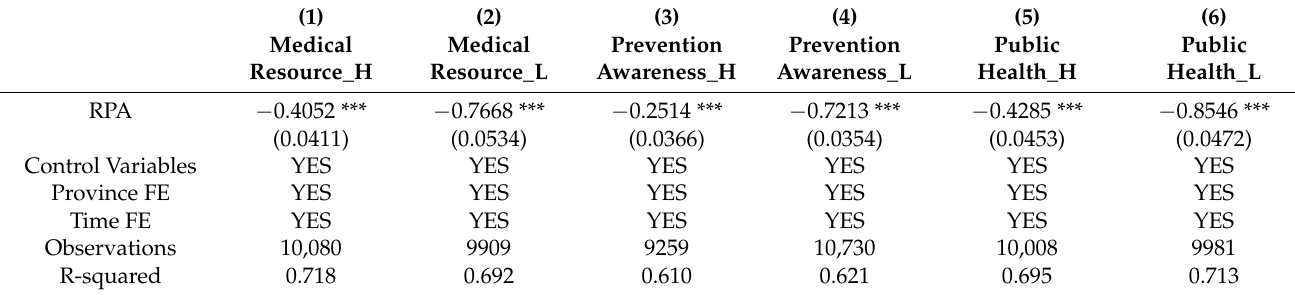
Table 5. Heterogeneity